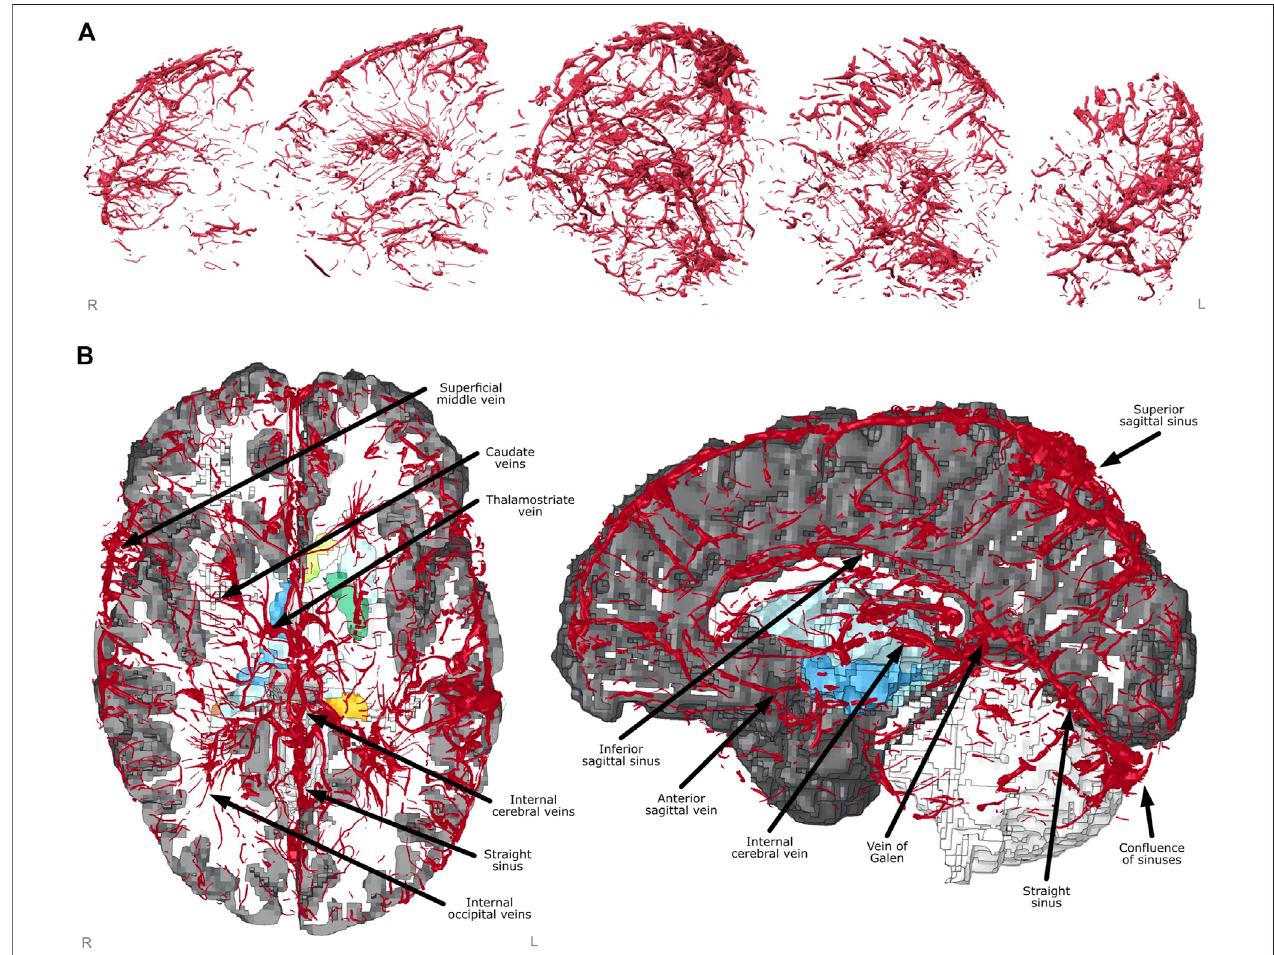
FIGURE3| Finiteelementmodelcreation. (A) Veinmeshsagittalcross-sectionsshowing fi nedetailcapturedfromsegmentationandmeshing. (B) Axialandsagittal views of FE model with sections cut away showing labelled venous system and subcortical structures underneath (coloured).